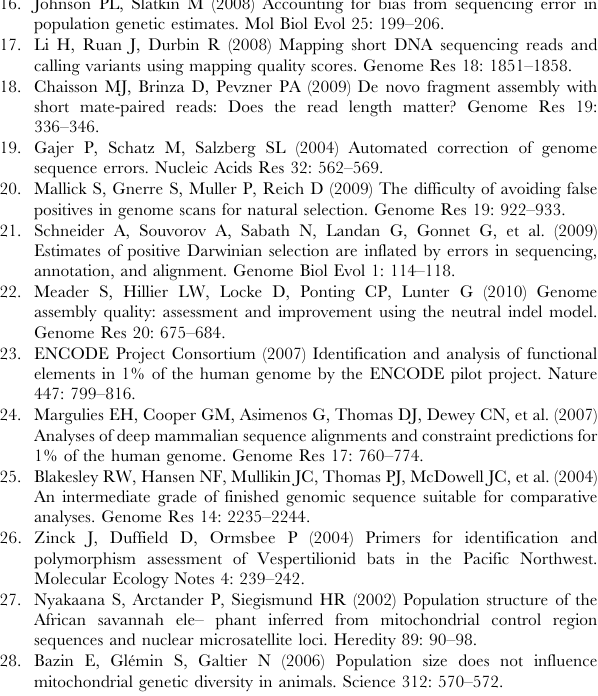
Table S1 Species nomenclature.